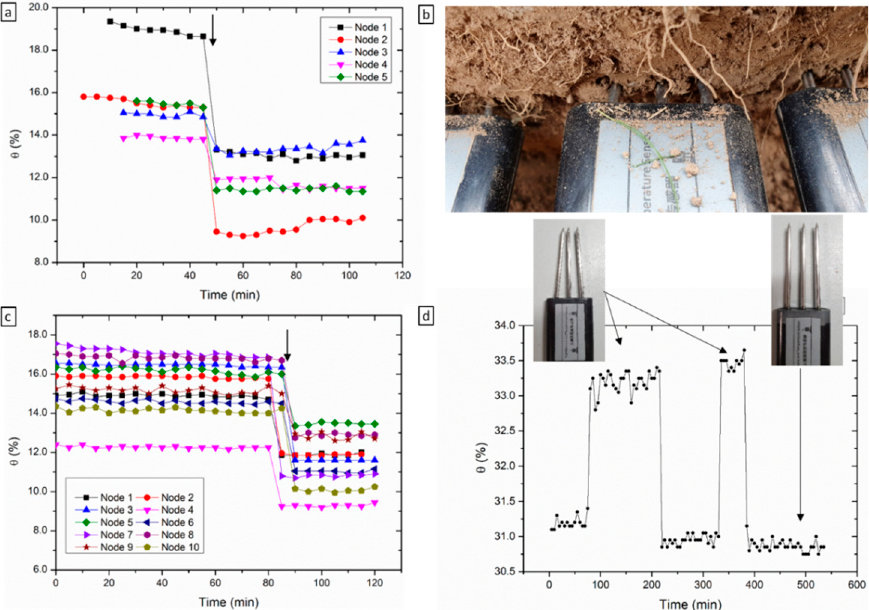
Figure 5. Errors and sources of errors associated with sensor installation. ( a ) Data showing sensor response before and after partial exposure to air—example provided in ( b ); ( c ) data showing sensor response before and after the presence of an air interface between the probe and soil—introduced through repeated shaking; ( d ) data drift associated with tines deflection;